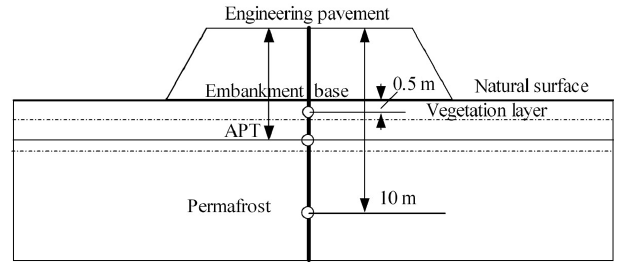
Figure 4. Schema of soil temperature measurements at (i) 0.5m depth beneath the embankment, (ii) near the artificial permafrost table, and (iii) at 10m depth.